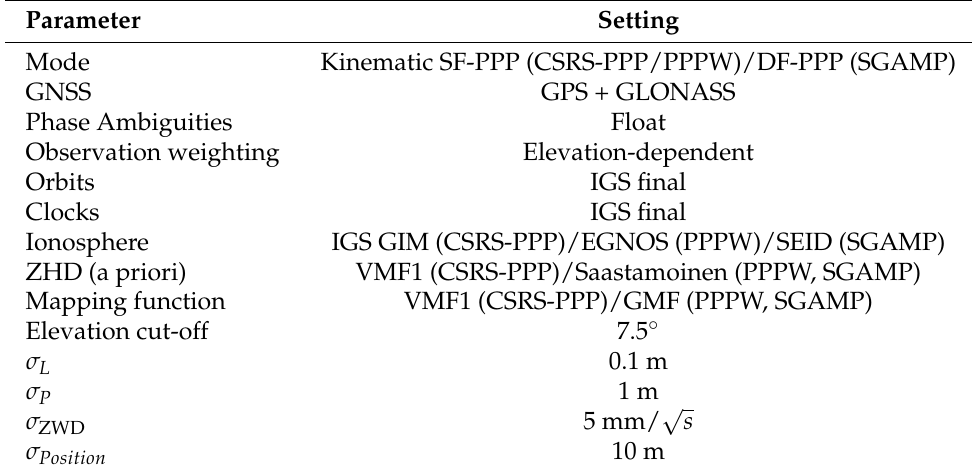
Table 1. General PPP settings used for the test